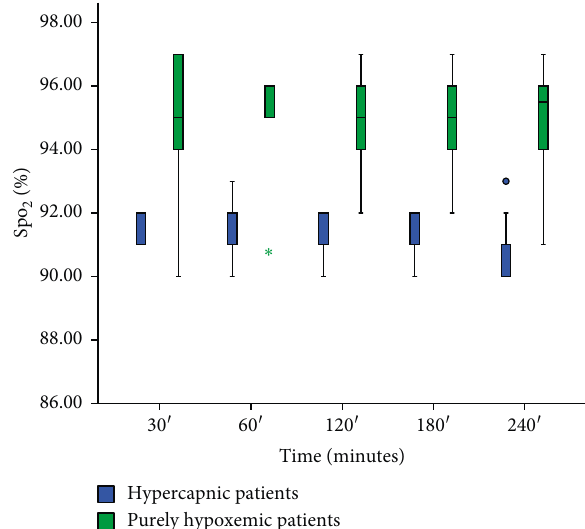
Figure 2: Oxygen saturation (SpO 2 ) of hypoxemic (green boxes) and hypercapnic (blue boxes) patients at various intervals during the application of the